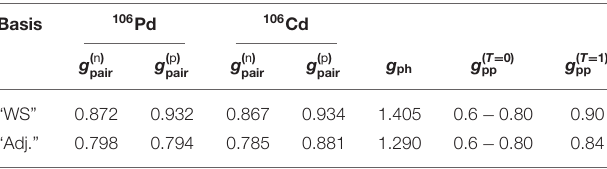
TABLE 2 | Adopted values of the pairing parameters of the BCS and the particle-hole and particle-particle parameters of the pnQRPA.